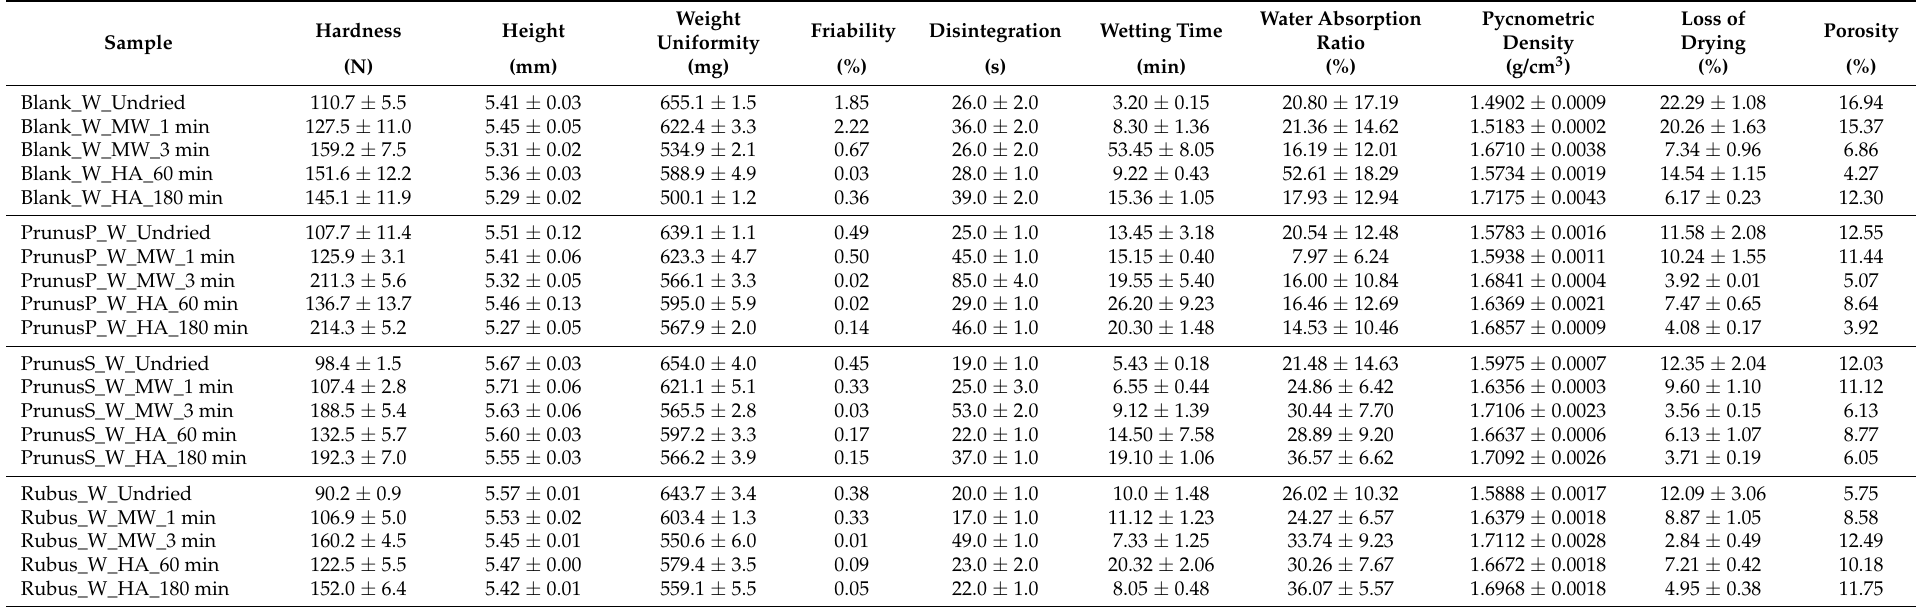
Table 4. Physico-mechanical evaluation of tablets with W plant